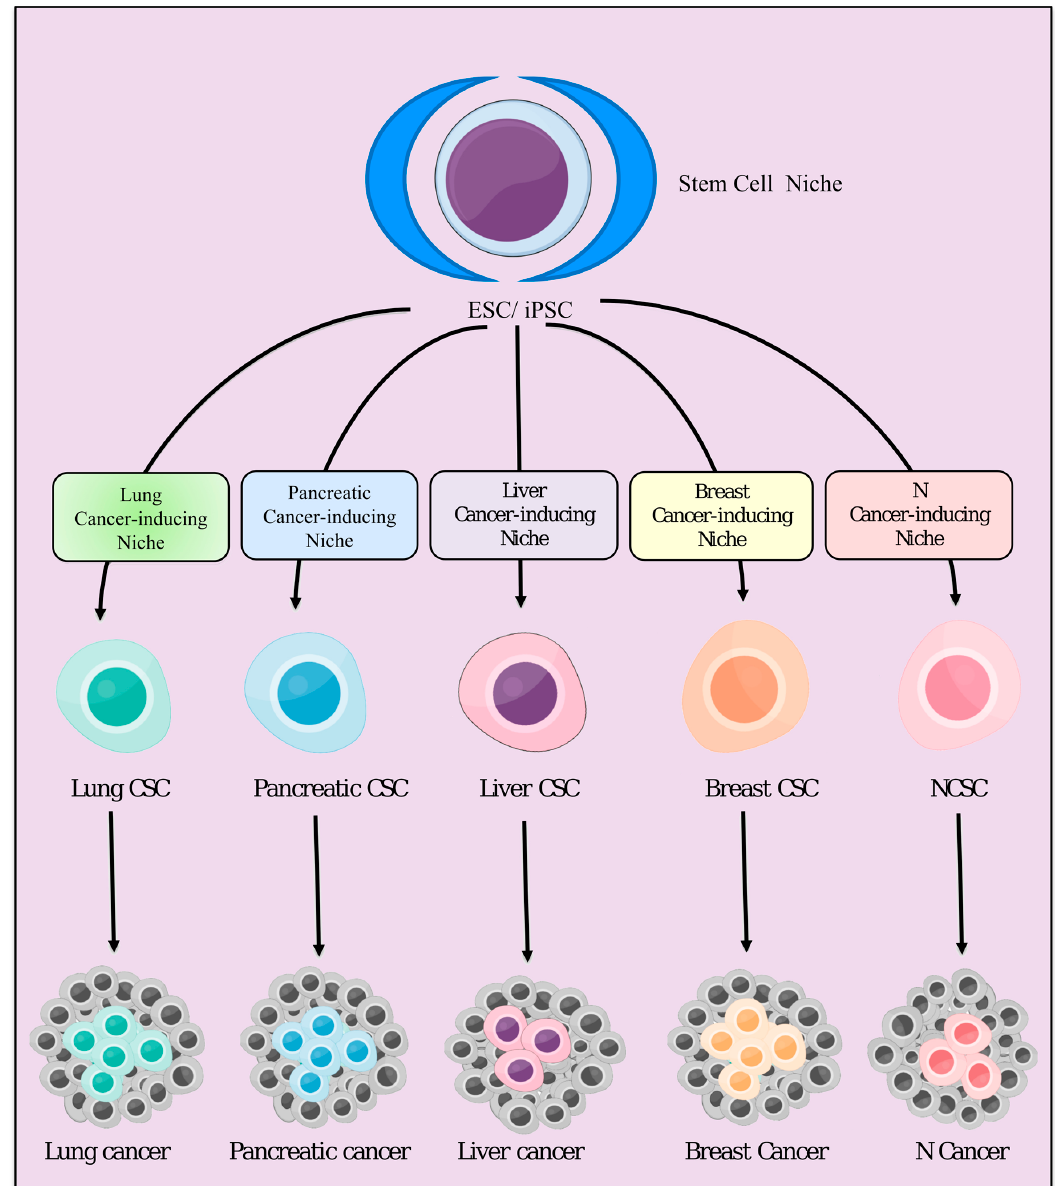
Figure 5. The hypothesis of stem cell (ESCs/iPSCs) differentiation under different cancer-inducing